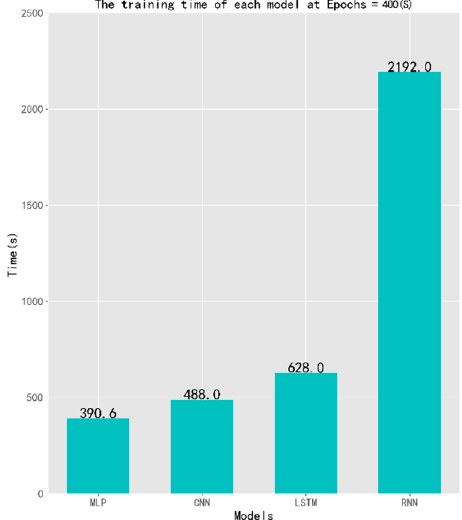
Figure 16. Loss values during training of the four models.